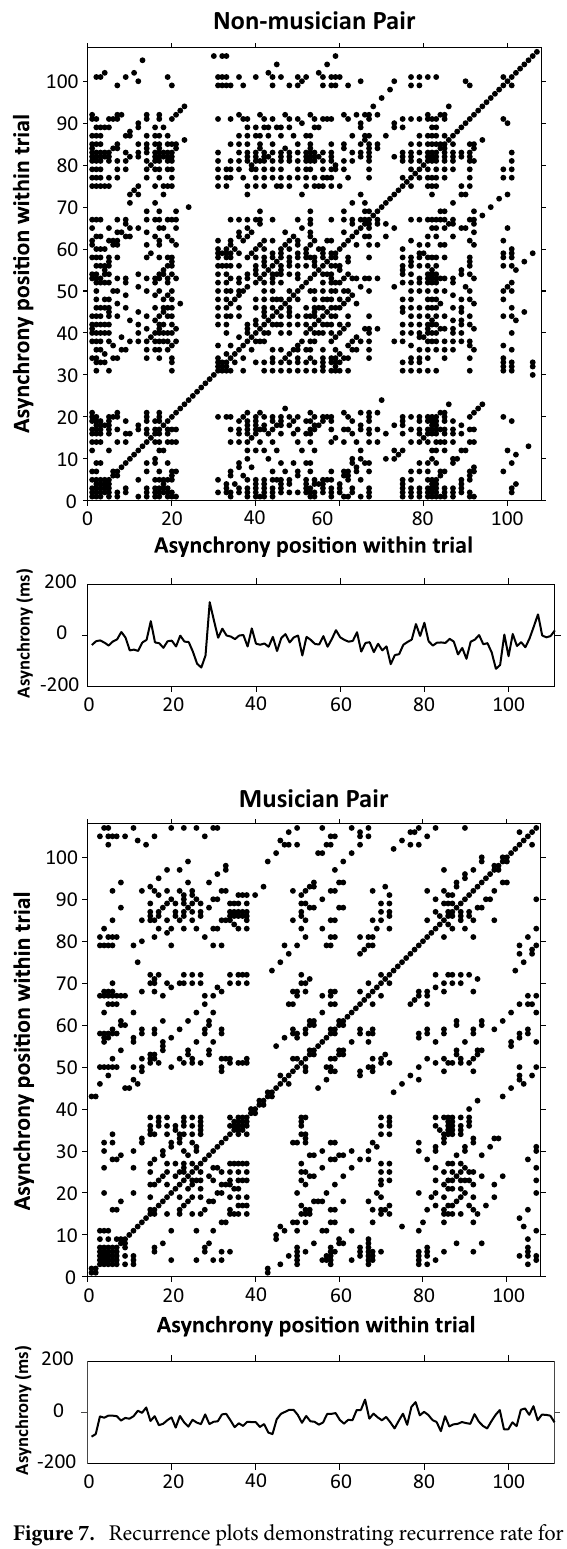
Figure 7. Recurrence plots demonstrating recurrence rate for sample trials (asynchronies) of Duet synchronization-continuation task. X- and y-axes indicate the asynchrony time series. Top: Non-musician pair’s recurrence rate (represented by percentage of points) = .1447. Bottom: Musician pair’s recurrence rate =